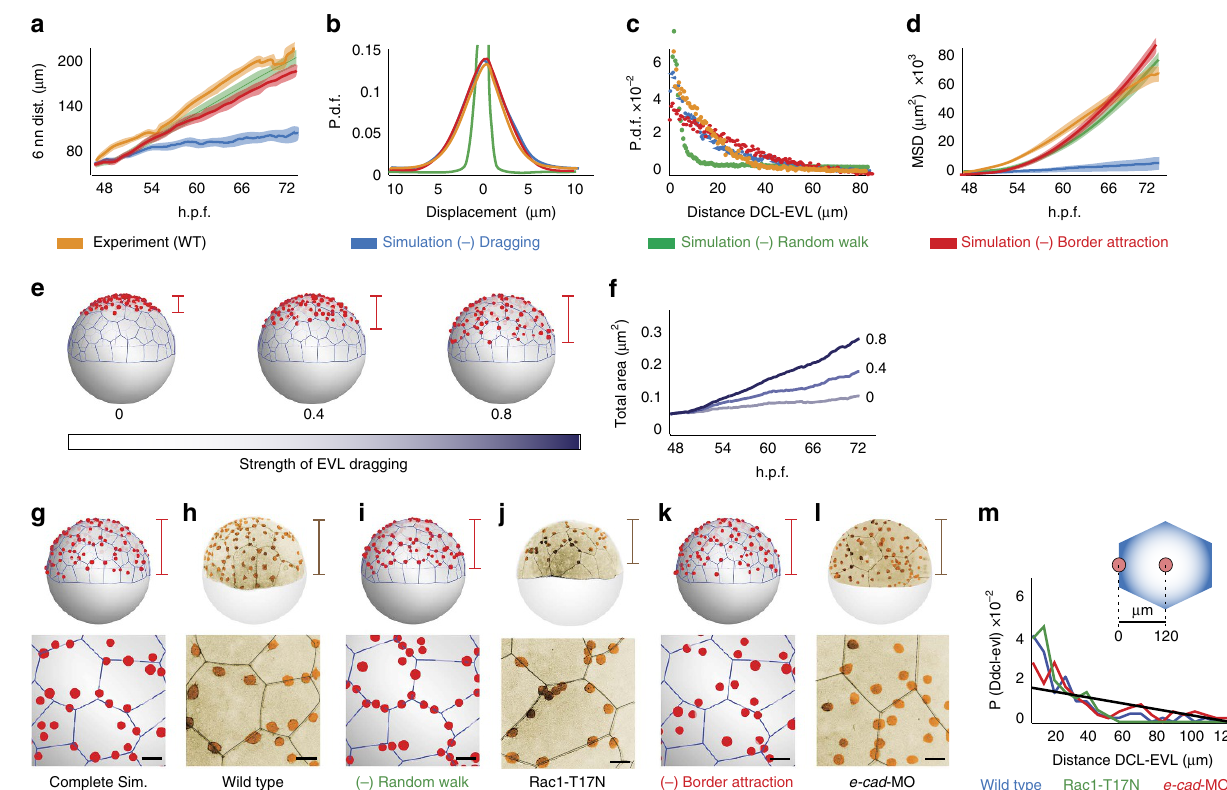
Figure 10 | Testing the role of autonomous and non-autonomous forces of DCL spreading. ( a – d ) Effects of the independent removal from simulations of autonomous random walk (green), EVL dragging (blue) and EVL cell border attraction (red), on the dynamic functions of DCL spreading defined in Fig. 9c–f ( e , f ). Effects of the gradual reduction of EVL dragging from simulations in the vegetal advancement of the DCL margin ( e ) and the total area covered by the DCL ( f ). The grayscale bar in ( f ) indicates the strength of EVL dragging (ranging from 0 – no drag, to 1 – maximum drag value as in simulations from Fig. 9c–f). ( g – m ) Comparison of results obtained from simulation predictions and experimental conditions that differentially affect random walk and EVL cell border attraction. In g – l , the vegetal advancement of the DCL is shown in the top panels (brackets) while the distribution of DCL cells with respect to EVL cell borders is shown at the bottom. ( g , i , k ) Effects of the independent removal from simulations of random walk ( i ) and EVL cell border attraction ( k ). ( h , j , l ) Phenotypes induced by experimental disruption of Rac1-mediated polarized cell protrusions (overexpression of Rac1-T17N) ( j ) and mild morpholino-mediated knock down of E-cad function ( l ). ( m ) Probability distribution of DCL cell position as a function of the distance to EVL cell borders in the conditions depicted in h , j and l . The black straight line corresponds to the expected random distribution for a mean EVL cell surface radius of 120 m m, as indicated in the top right corner. Scale bar, 50 m m (bottom g – l Genomic DNA extraction . For genomic DNA extraction, one or two embryos domain database from NCBI (http://www.ncbi.nlm.nih.gov/Structure/cdd/ wrpsb.cgi). were transferred to a microfuge tube, the embryo medium removed with a pasteur pipette and 100 m l of lysis buffer (10mM Tris pH 8.2, 10mM EDTA pH 8, 200mM NaCl, 0.5% SDS, 200 m gml (cid:2) 1 Proteinase K) was added. Embryos were then E-cadherin knock-down by morpholino antisense oligonucleotides . Splice- incubated at 50 (cid:2) C for at least 3h with occasional gentle swirling. The mixture was inhibiting MOs were obtained from Gene Tools, maintained in nuclease-free water cooled at RT, extracted with one volume of phenol:chloroform:isoamyl alcohol at a final concentration of 1mM, and stored at (cid:2) 80 (cid:2) C. MO sequences used were: (25:24:1) and centrifuged for 10min at 5,000 (cid:3) g. The upper phase was carefully e-cad -MO, 5 0 -CATCATTTTCAAGTTCTTACGTCAA-3 0 ; Control-MO, 5 0 -CCT removed and DNA precipitated by adding 1:10 volume of sodium acetate pH 6 and two volumes of ethanol. The precipitated DNA was removed by using the pasteur pipette and transferred into a tube containing 70% ethanol. The DNA pellet was stood in 70% ethanol for about 5min and gently moved it around from time to time using the pasteur pipette. Finally, the DNA was removed from the 70% ethanol with a pasteur pipette, letting the excess liquid to drip off, and placing the pasteur pipette with DNA sticking to it inverted into a microfuge rack. DNA was air dried for 5min and resuspended in TE buffer.